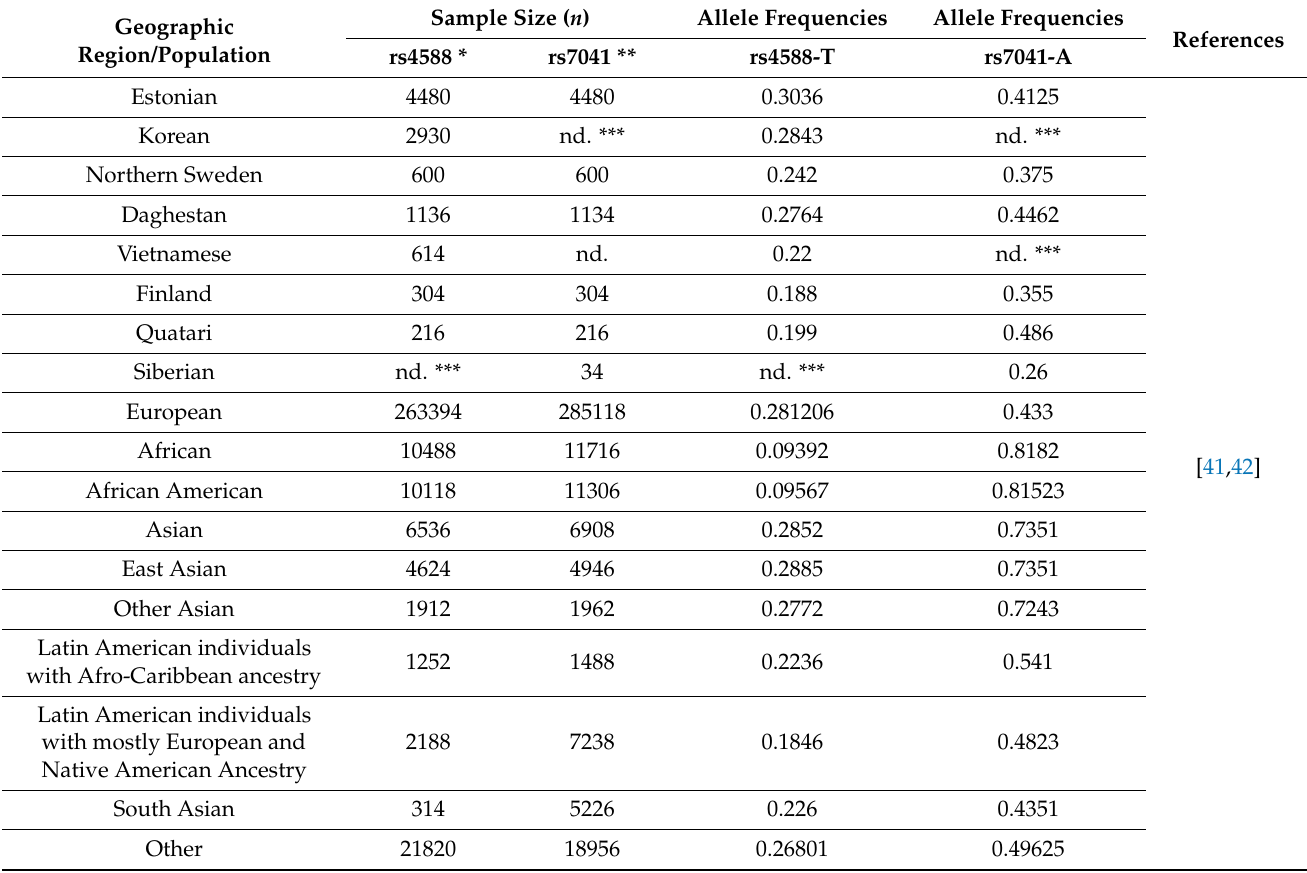
Table 3. Frequencies of alleles in rs4588 and rs7041 among different populations and geographic regions based on